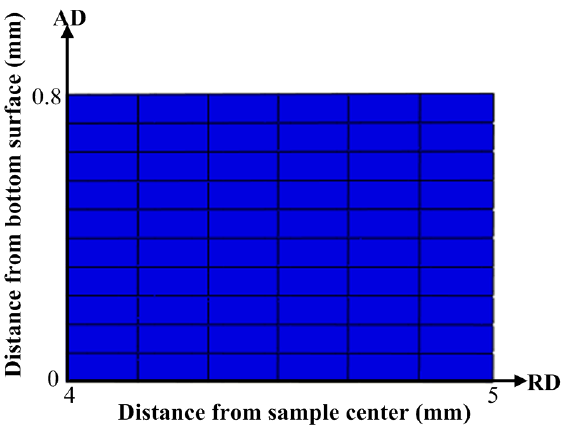
Figure 3. Schematic description of the region selected for grain detection.